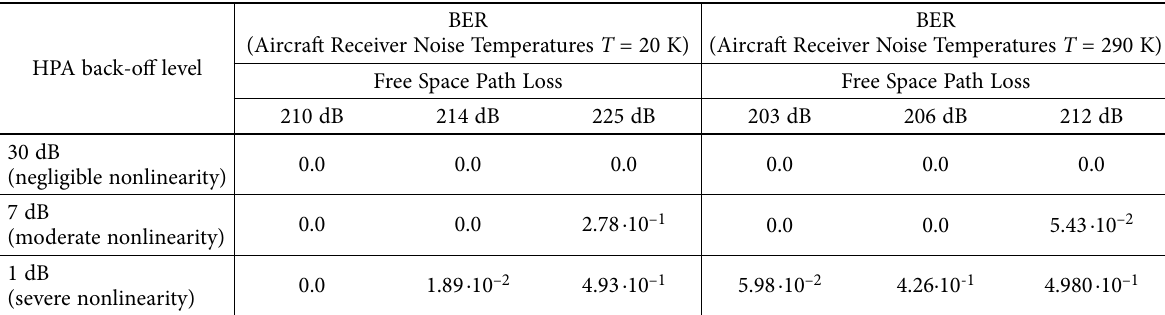
Table. Dependence of error probability for BPSK modulation scheme on satellite HPA nonlinearity